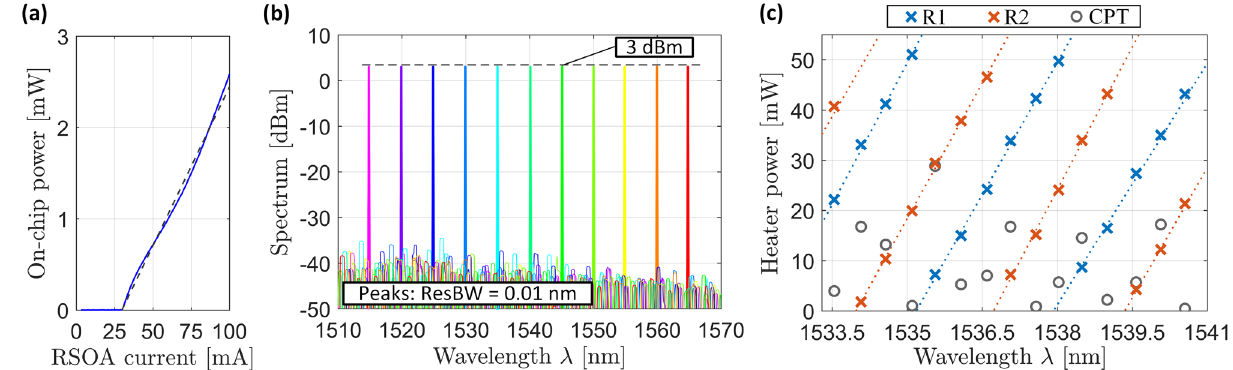
Figure 5. Device characterization results. ( a ) P – I -curve recorded for lasing operation at 1550 nm. A threshold current of 30 mA and slope efficiency of roughly 35 mW/A are found from the measurement. The output power P refers to the on-chip power in the bus waveguide between R2 and GC 4, see Fig. 1b. ( b ) Superimposed lasing spectra recorded in steps of 5 nm within the single-mode tuning range between 1515 and 1565 nm, covering the complete telecommunication C-band. The RSOA bias current was adjusted for each operating point to maintain a constant output power level of 3 dBm. We verify longitudinal single-mode operation by observing the full emission spectrum across the entire RSOA gain bandwidth, finding an SMSR that is consistently better than 40 dB. ( c ) Tuning map of the laser emission, indicating the heater powers of the rings R1 and R2 (blue and red crosses) and of the cavity phase tuner (CPT, grey circles) to reach a certain target wavelength. For better visibility, we only plot a small part of the overall tuning range. The fitted ramps (dotted lines) for the ring heater powers serve as a guide to the eye. The vertical offset of the fitted ramps corresponds to twice the π-power P π of the respective ring heater, which is independently measured to be P π ,R1 = 24.4 mW for R1 and P π ,R2 = 24.1 mW for R2, see Supplementary Section